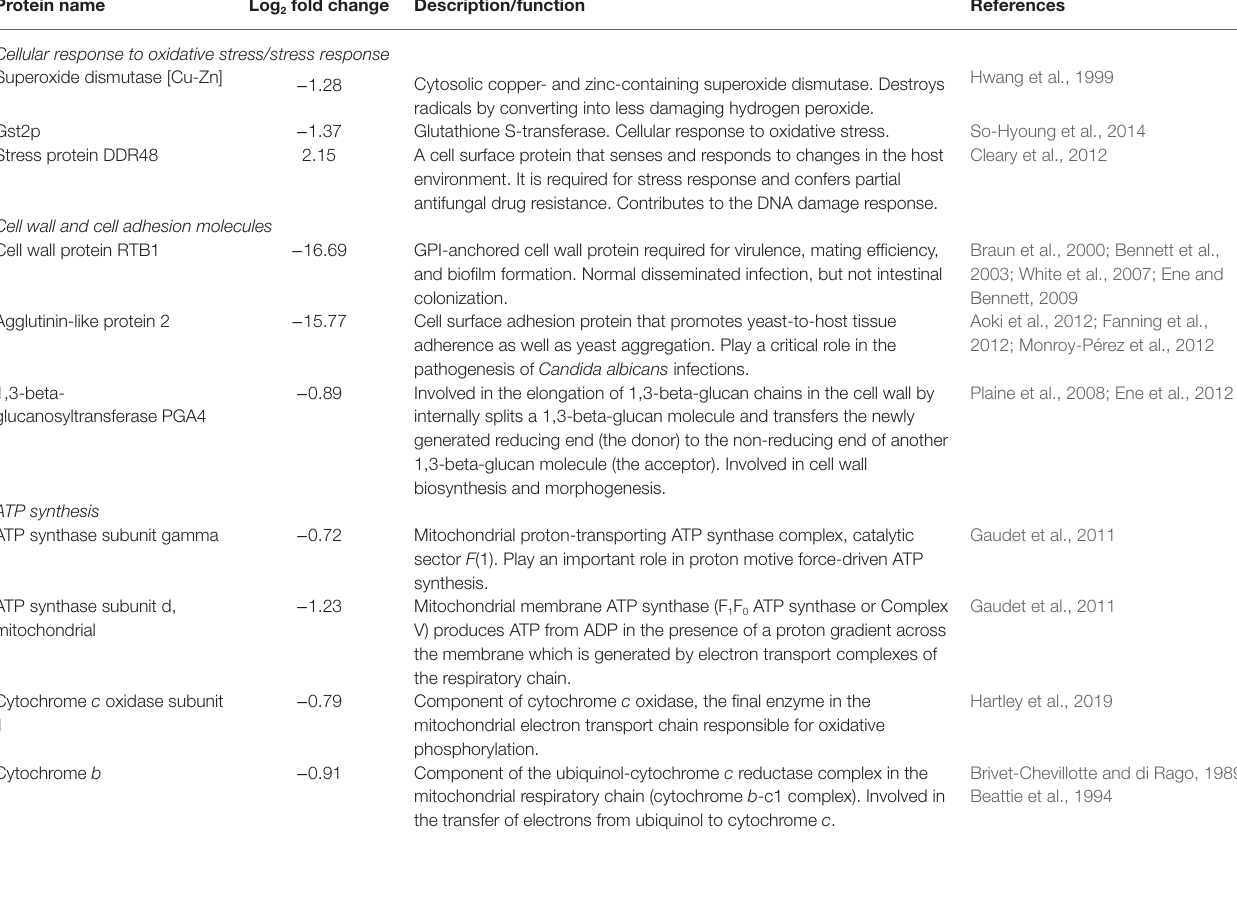
TABLE 3 | A list of interesting proteins influenced by β -citronellol treatment. Protein name